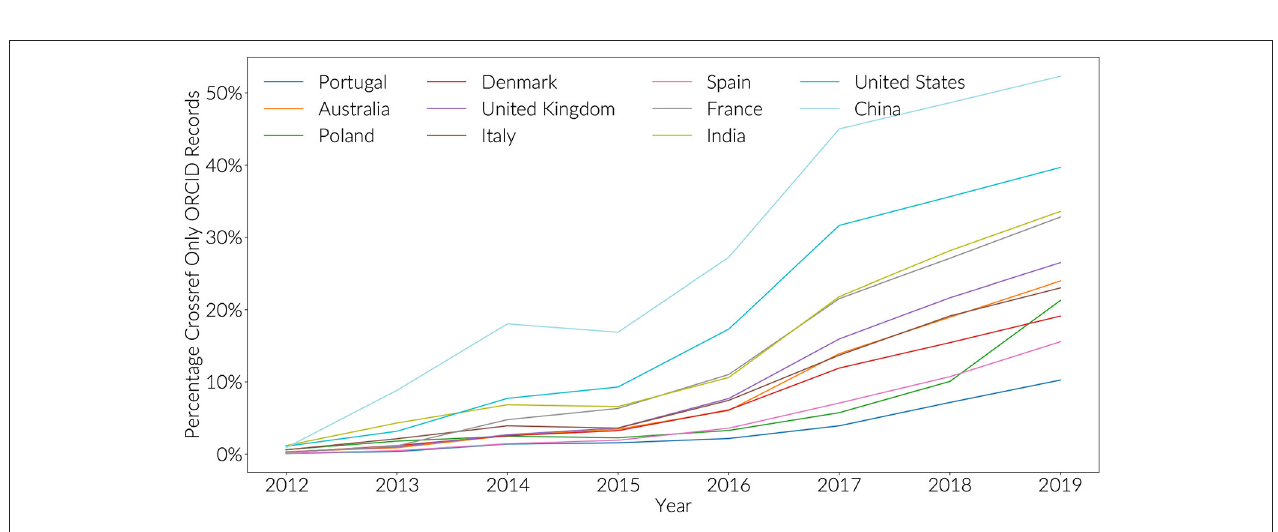
FIGURE 4 | Percentage of ORCID records with only Crossref assertions by